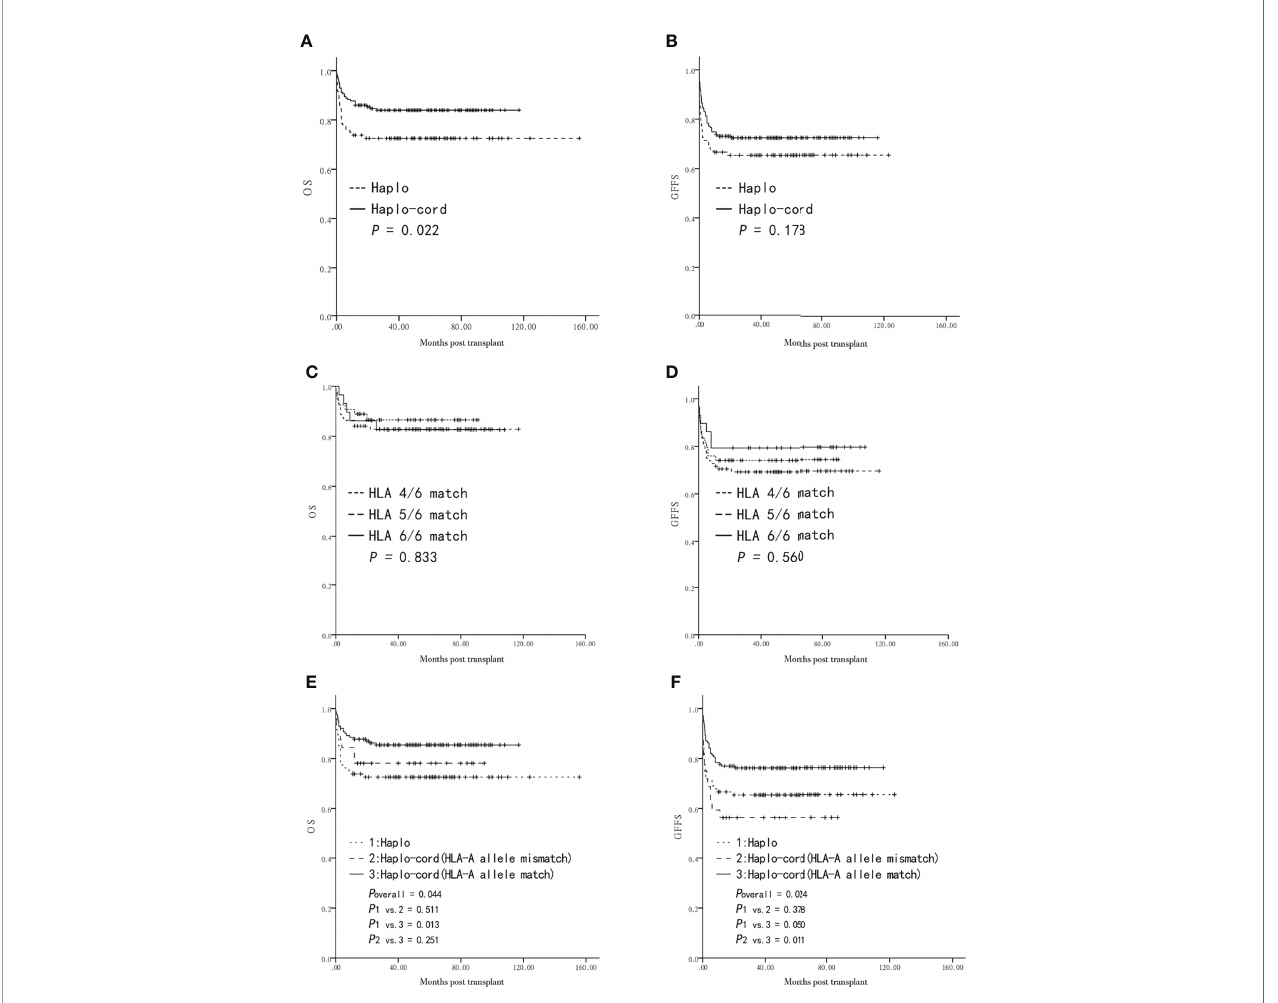
FIGURE 2 | Overall survival (OS) and GVHD-free and failure-free survival (GFFS) after transplantation from Haplo-HSCT or Haplo-cord-HSCT (including subgroups). (A) OS between the two groups. (B) GFFS between the two groups. (C) OS among HLA 4, 5, 6 Haplo-cord-HSCT subgroups. (D) GFFS among HLA 4, 5, 6 Haplo- cord-HSCT subgroups. (E) OS among Haplo-HSCT group and Haplo-cord with a HLA-A match or mismatch subgroups. (F) GFFS among Haplo-HSCT group and Haplo-cord with a HLA-A match or mismatch